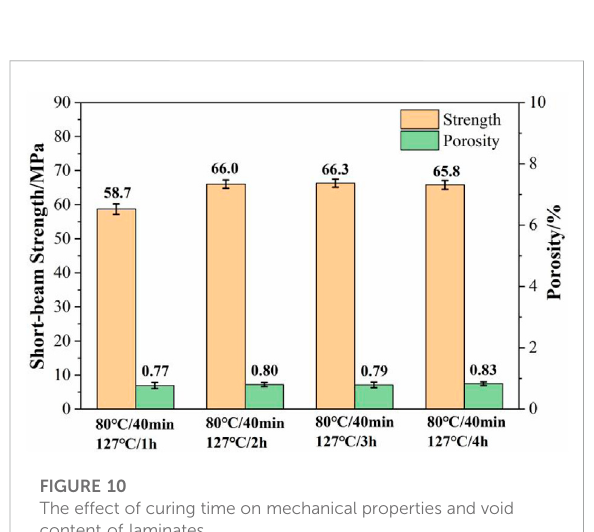
FIGURE 10 The effect of curing time on mechanical properties and void content of laminates.